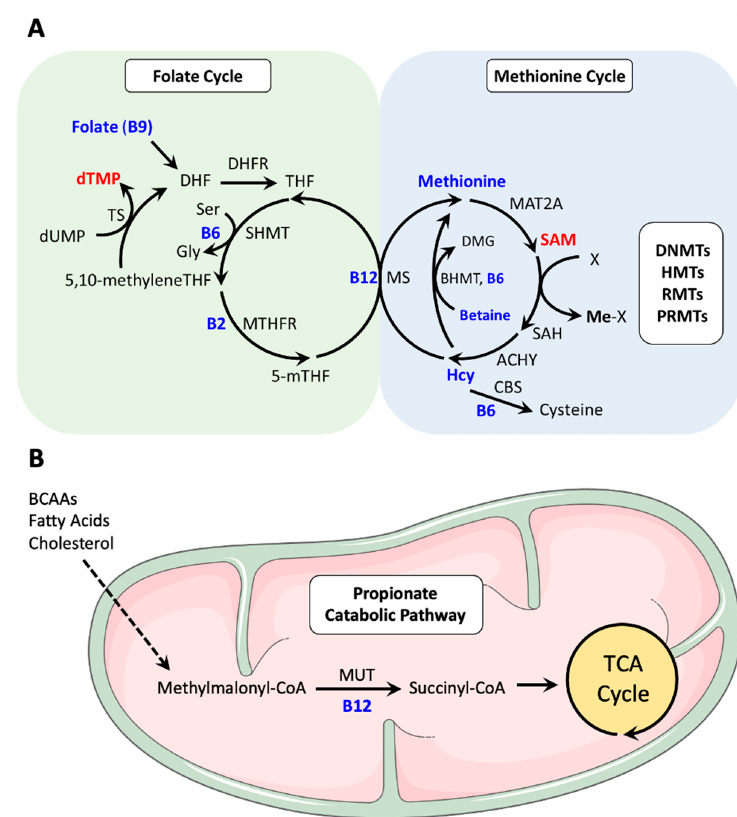
Figure 1. The regulation of metabolism by B vitamins. ( A ) B vitamins in one-carbon metabolism. The folate cycle begins with the conversion of dietary folate (B9) into dihydrofolate (DHF), which is then reduced to tetrahydrofolate (THF) by the enzyme dihydrofolate reductase (DHFR). THF is next converted to 5,10-methyleneTHF by serine hydroxymethyltransferase (SHMT), a reaction that is coupled with the hydroxylation of serine (Ser) to glycine (Gly) and requires B6 as a cofactor. Thymidylate synthase (TS) uses 5,10-methyleneTHF as a methyl donor to methylate deoxyuridine monophosphate (dUMP), creating deoxythymidine monophosphate (dTMP). This step regenerates DHF for continued cycling. Alternatively, 5,10-methyleneTHF can be reduced by methylenetetrahydrofolate reductase (MTHFR) to 5-methytetrahydrofolate (5-mTHF) using B2 as a cofactor. As part of the methionine cycle, 5-mTHF donates a methyl group to regenerate methionine from homocysteine (Hcy), which is catalyzed by methionine synthase (MS) and requires B12, in the form of methylcobalamin, as a cofactor. To generate the methyl donor S-adenosylmethionine (SAM) for use by multiple methyltransferases (MTs) specific for RNA (RMT), DNA (DNMT), histones (HMT), and protein (PRMT) methylation reactions, an adenosine is transferred to methionine by methionine adenosyltransferase 2A. SAM is demethylated during the methyltransferase reactions to form S-adenosylhomocysteine (SAH) that is then hydrolysed by S-adenosylhomocysteine hydrolase (AHCY) to form Hcy. Hcy can also enter the transsulfuration pathway catalyzed by cystathionine beta synthase (CBS) and vitamin B6 to create cysteine. In the liver, betaine from the diet can act as a methyl donor for betaine-homocysteine S-methyltransferase (BHMT), using B6 as a cofactor, to make methionine and dimethylglycine (DMG) as a byproduct. Important dietary micronutrients and metabolite intermediates are highlighted in blue. Items in red are important byproducts of one-carbon metabolism. ( B ) B12 and propionate metabolism. The propionate catabolic pathway breaks down branched-chain amino acids (BCAAs), odd-chain fatty acids, and cholesterol to be used in the tricarboxylic acid (TCA) cycle in the mitochondria. Methylmalonyl-CoA mutase (MUT) converts methylmalonyl-CoA into succinyl-CoA using B12, in the form of adenosylcobalamin, as a cofactor. Succinyl-CoA then enters the TCA